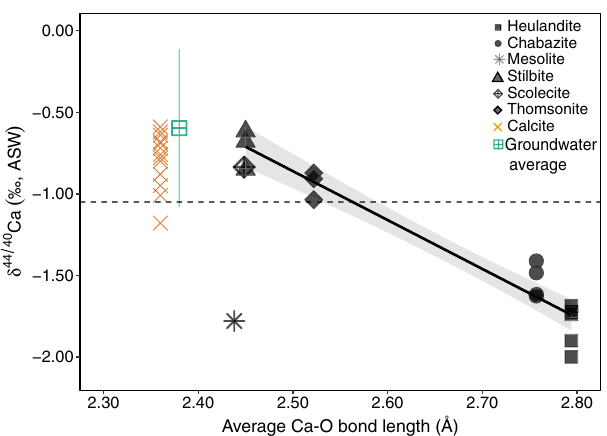
Fig. 4 Zeolite δ 44/40 Ca versus estimated average Ca – O bond length. Symbol size encompasses the external reproducibility (±0.05 ‰ , 2 σ SD ). Also shown are δ 44/40 Ca data for calcite from this study and zeolite-zone calcite from Jacobson et al. (2015), as well as the average of natural groundwaters 21 and pre-injection groundwaters from the CarbFix1 site 29 , which circulate through active zeolite zones analogous to the extinct system studied here 65 . Calcite 106,136 and groundwater 96 Ca-O bond lengths are approximate. The black dashed line shows the average value for Icelandic basalt ( − 1.05 ‰ ) determined from this study and Jacobson et al. (2015). Average Ca – O bond lengths and δ 44/40 Ca values of bulk zeolites strongly correlate ( R 2 = 0.93, p < 0.001), when mesolite is excluded from the regression. The grey shading represents the con fi dence interval of this regression (see Supplementary information (S1) for details of the statistical